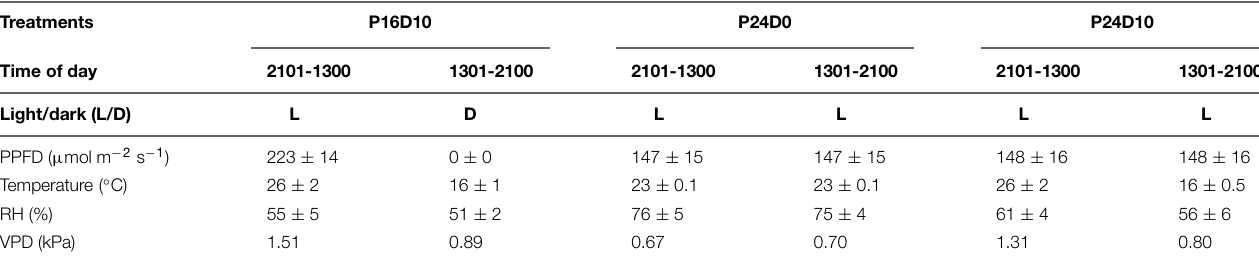
TABLE 1 | Daily mean (diurnal) climate data applied for the three growth conditions (P16D10, P24D0, P24D10). Treatments P16D10 P24D0 P24D10 Time of